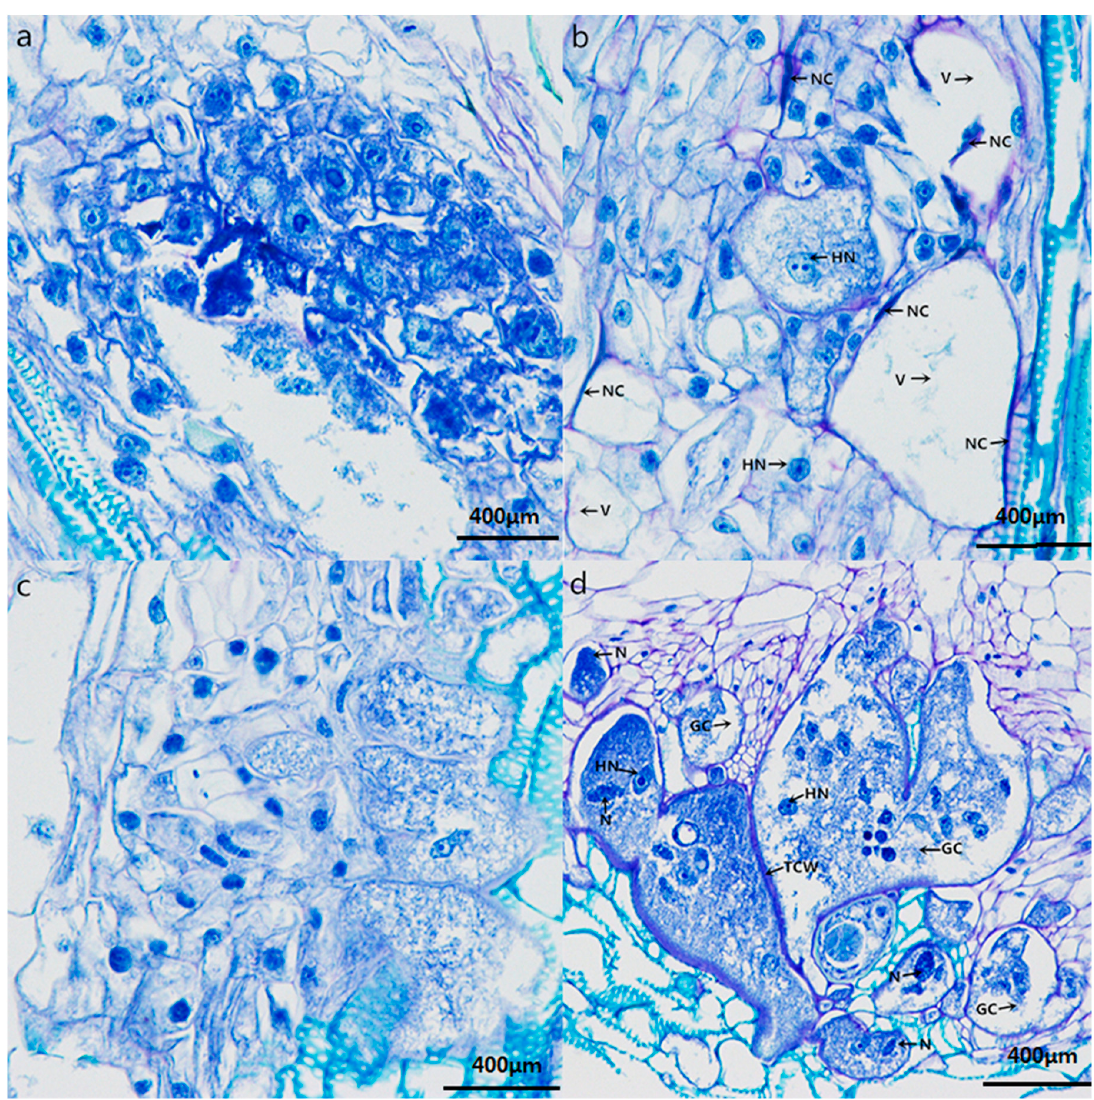
Figure 3. Histopathological observation between resistant and susceptible tobacco cultivars inoculated with nematodes. ( a , b ) are RC and RI root sections. ( c , d ) are SC and SI root sections. GC, giant cell; N, nematode; NC, necrosis cell; V, vacuole; HN, hypertrophied nucleus; TCW, thickened cell wall.